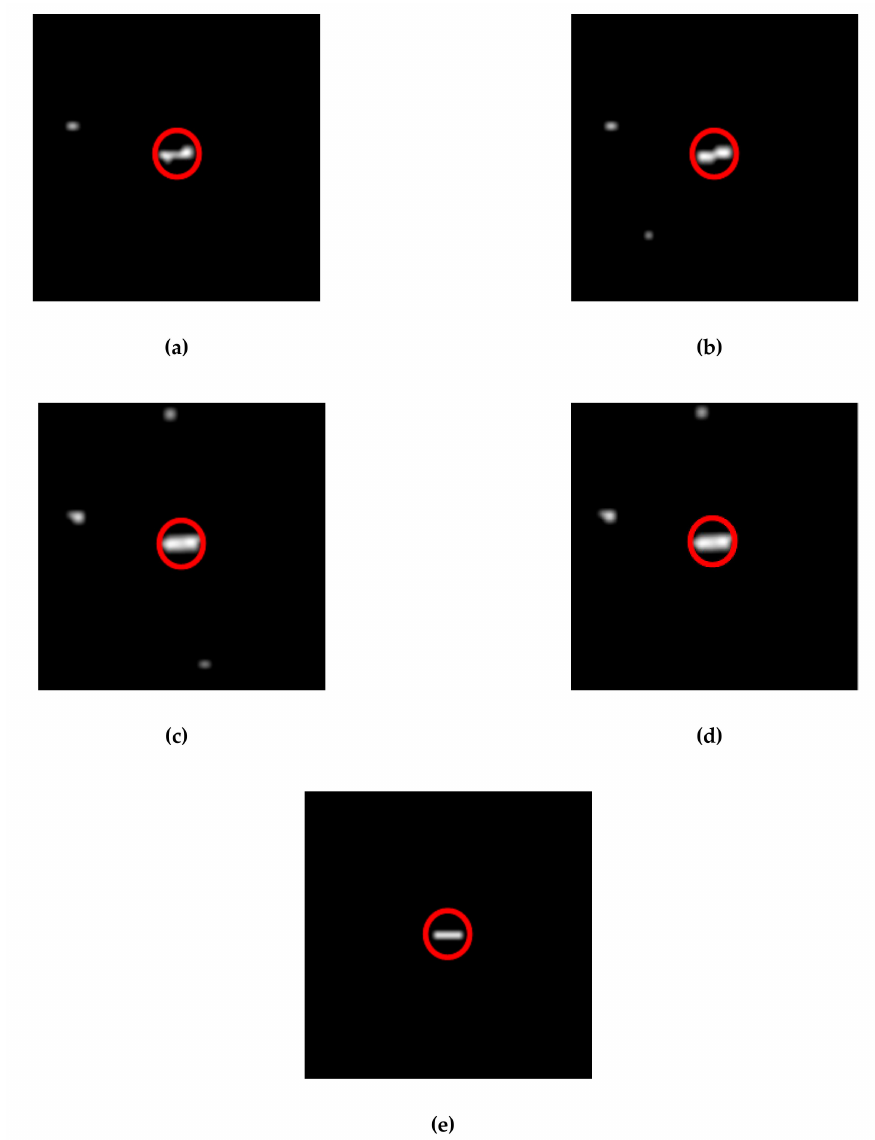
Figure 10. The obtained photovoltaic panel abundance fraction and classification maps for the real sub-image 1: ( a ) Grd-Part-NMF, ( b ) Multi-Part-NMF, ( c ) Grd-NMF, ( d ) Multi-NMF and ( e ) one-class-classification-based. Red circles surround photovoltaic